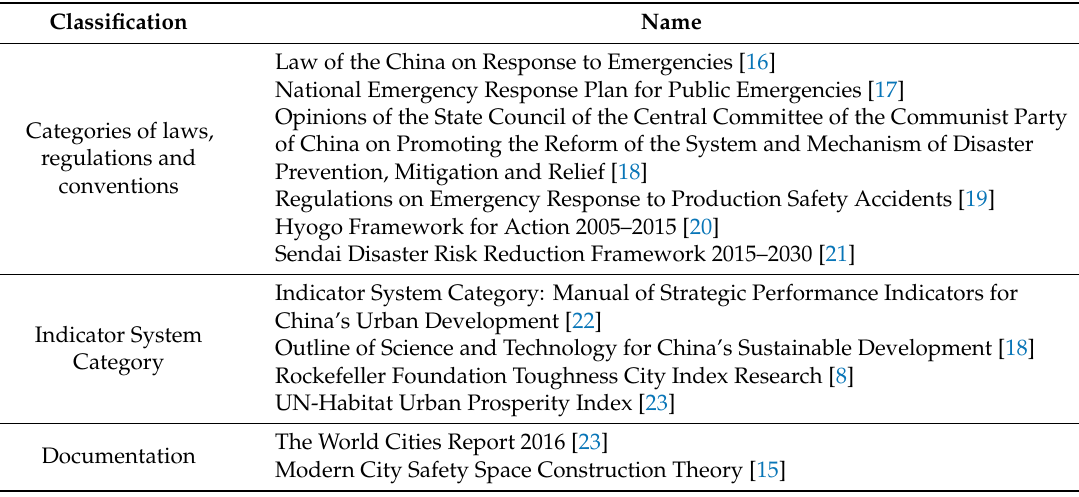
Table 1. Reference Basis for Selecting